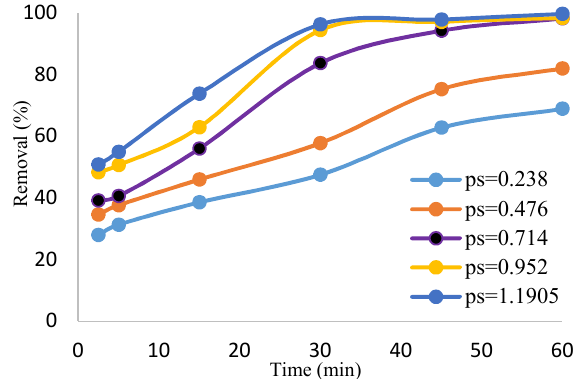
Fig. 4. Changes in the removal efficiency of erythrombin B dye in different concentrations of persulfate in the US/S 2 O 82- process (pH:3; concentration of erythrosine B dye, 50 mg/L)